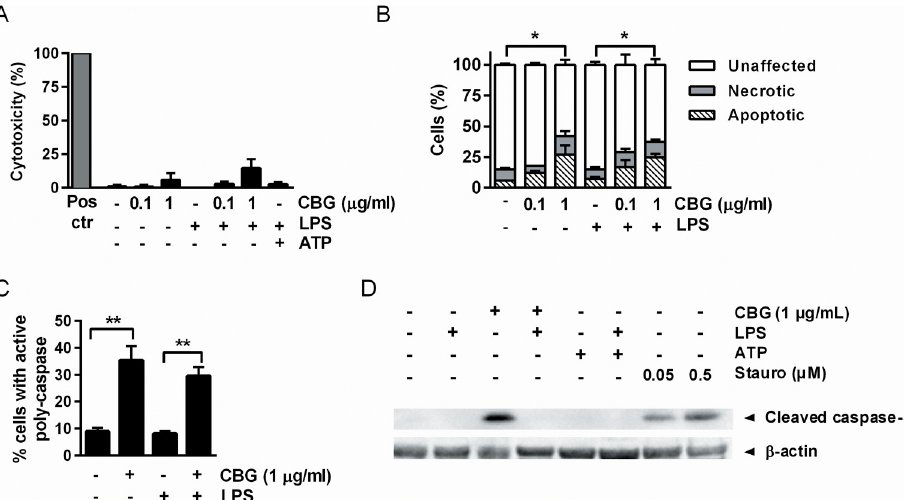
Fig 3. CBG exerts pro-apoptotic effects associated with caspase activation. DCs were stimulated with vehicle or CBG in the absence or presence of LPS (100 ng/ml) for 24 hours. (A) Supernatants were collected and analyzed for lactate dehydrogenase (LDH) release. Data shown represent means + SEM for 4 donors. Pos ctr, positive control (lysis with detergent; 100%). (B) Cell apoptosis and necrosis was examined by analyzing the percentage of Annexin V + or Annexin V + and PI + cells, respectively. Data shown represent means + standard deviation (SD) for 1 donor, and are representative of the results of 3 donors. (C) Active caspases were detected with the FAM FLICA Poly Caspase Assay Kit, and data shown represent means + SEM for 4 donors. (D) Whole-cell extracts were prepared, and equal amounts of lysates were analyzed by Western blot using an antibody against caspase-3. β -actin was used as a loading control. The results shown are representative of three independent experiments. * P < 0.05. ** P < 0.01.